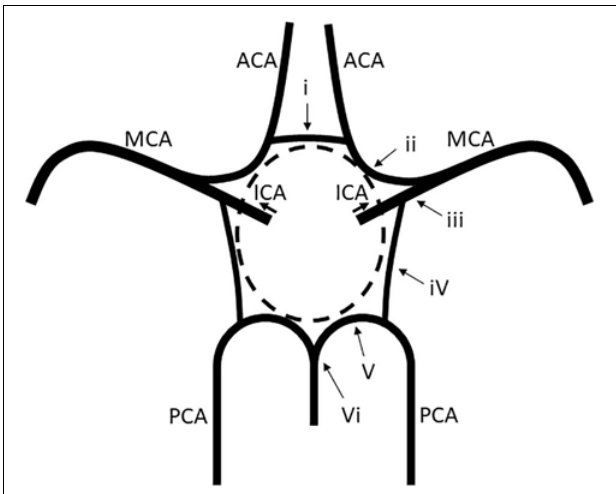
FIGURE 1 | Vessels constituting the circle of Willis. (i) The AComA, (ii) the A1 segment of the ACAs, (iii) the intracranial ICA beyond the PComA bifurcation, (iv) the PComAs, (v) the P1 segment of the PCAs, and (vi) the top of the BA. ACAs, anterior cerebral arteries; AComA, anterior communicating artery; BA, basilar artery; ICAs, internal carotid arteries; PCAs, posterior cerebral arteries; PComAs, posterior communicating